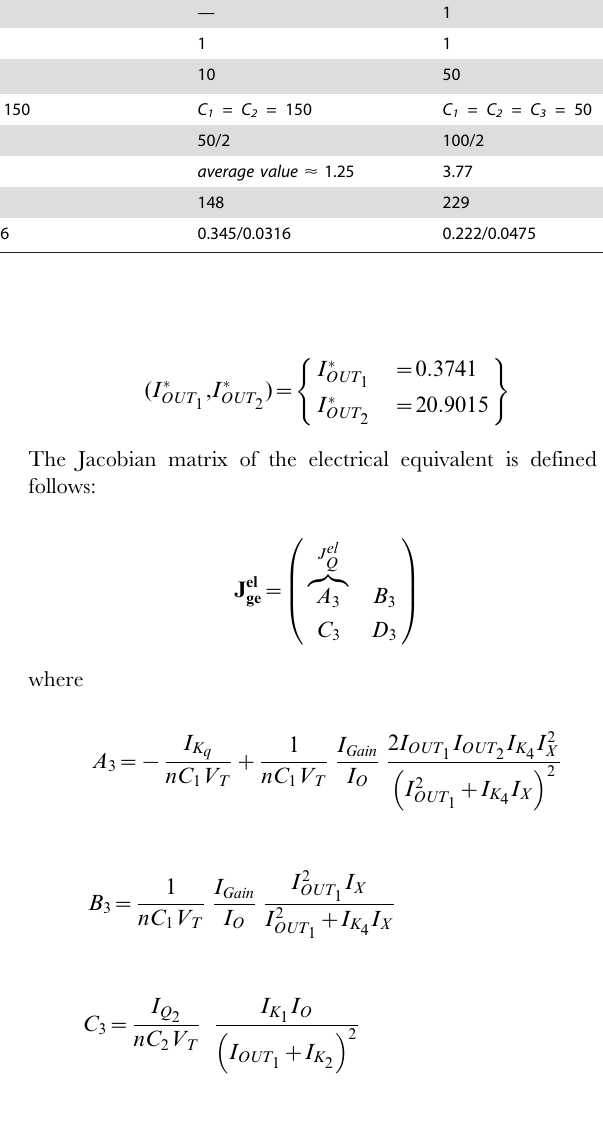
Type Of Log-Domain